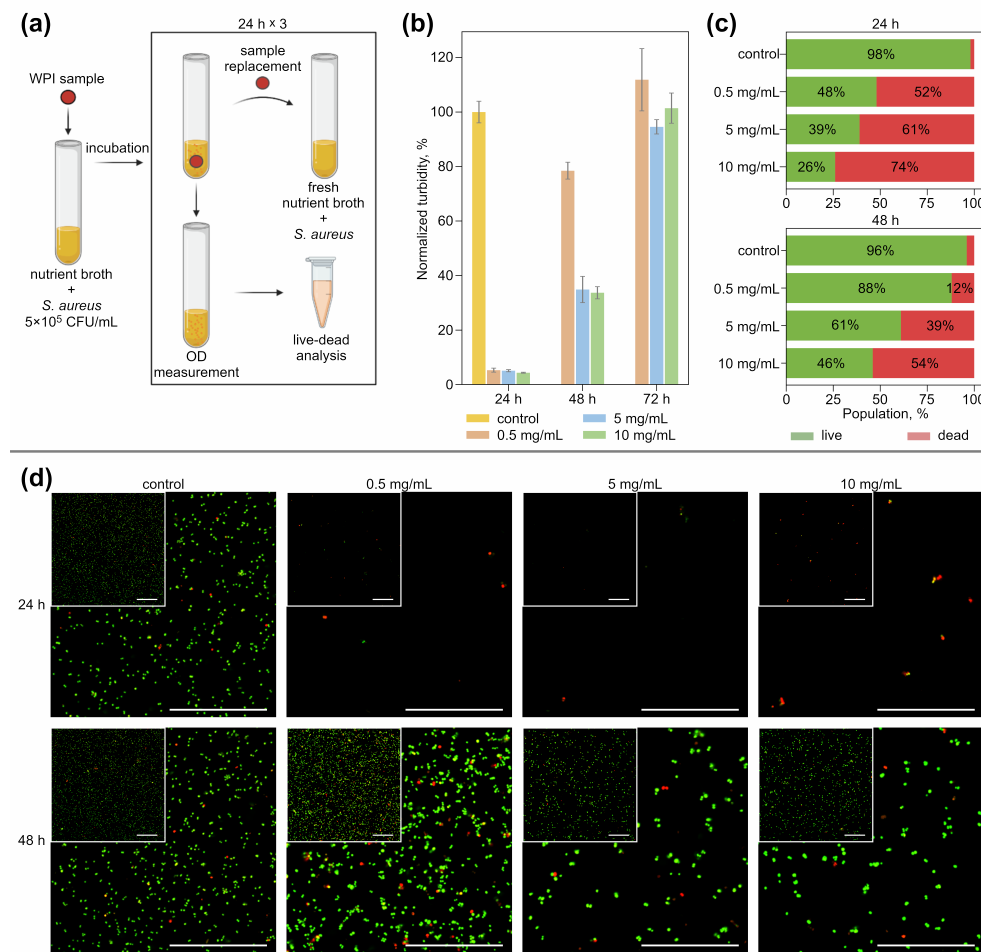
Figure 3. ( a ) The principal experiment scheme to study the antibacterial activity of WPI-based hydrogels with cefazolin in liquid media. ( b ) Total number of bacteria in nutrient broth compared with control ( c ) live–dead analysis of experimental bacterial suspension by flow cytometry. ( d ) CLSM images of bacterial suspensions after incubation with cefazolin-containing hydrogel samples. Green color indicates live bacteria (Syto 9), red color indicates dead ones (PI). The scale bar in all images is 50 µ